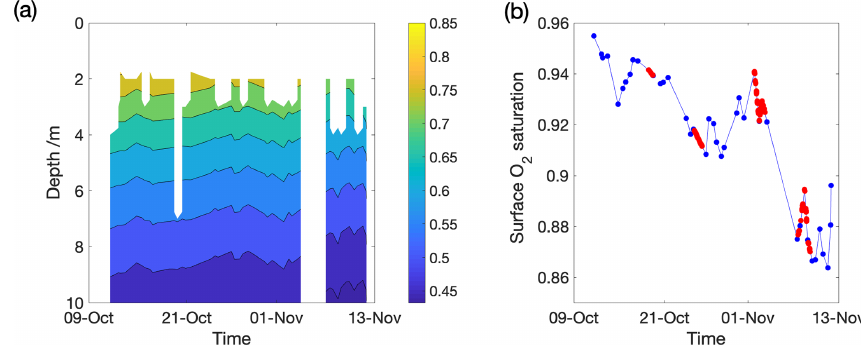
Figure 9. (a) Oxygen saturation calculated from the CTD casts shown as the relative saturation at each depth rather than the more conventional normalisation to surface saturation. 43 CTD casts were made during the 35d cruise and the data gap was during the transit to the Gulf Stream. In all cases, the oxygen was well-mixed, so the actual concentration was similar at 10 and at 2m. The highest depth measurement of each CTD cast varies because the measurements were taken at fixed time intervals rather than at fixed depths. (b) The oxygen saturation at the ocean surface estimated from the data shown in (a) . Red markers show the four